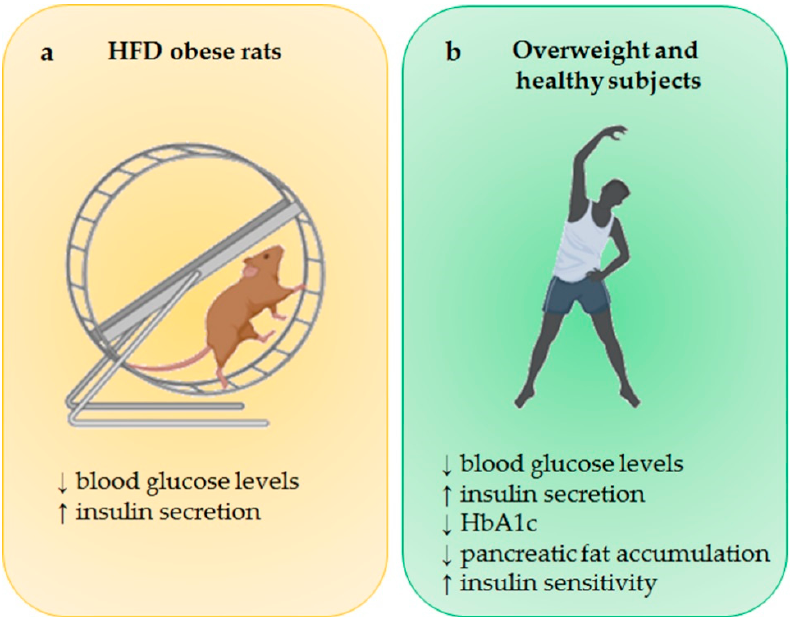
Figure 1. Effect of physical activity (PA) on β -cell function. ( a ) Physical activity reduces blood glucose levels and increases insulin secretion in HFD-induced obese rats compared to sedentary control group. ( b ) In both overweight and healthy subjects, physical activity exerts a beneficial effect on glucose homeostasis, improving insulin secretion and sensitivity and leading to a reduction in HbA1c. BioRender software was used for art work. HFD, high fat diet; HbA1c, hemoglobin A1c.